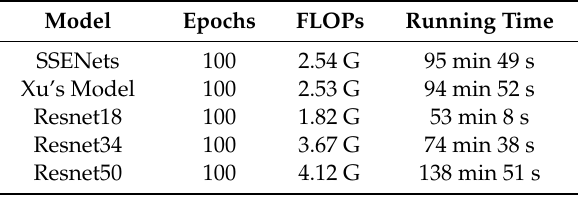
Table 10. Computational e ffi ciency and complexity of